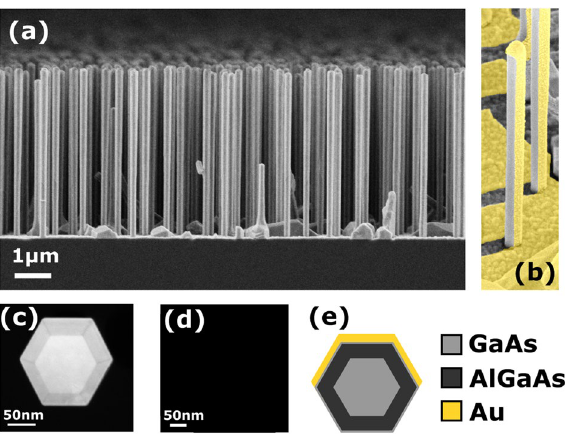
Figure 1. Structural details of the investigated NWs. ( a ) SEM edge view the sample with NWs 4690 ± 80 nm long, of the overall diameter 197 ± 9 nm. ( b ) False color SEM image of the NWs after Au deposition. ( c ) Cross-sectional dark-field TEM micrograph showing GaAs core, AlGaAs shell and GaAs supershell. ( d ) Cross- sectional TEM image of the NW asymmetrically covered by Au. ( e ) Cross-sectional sketch of the NW